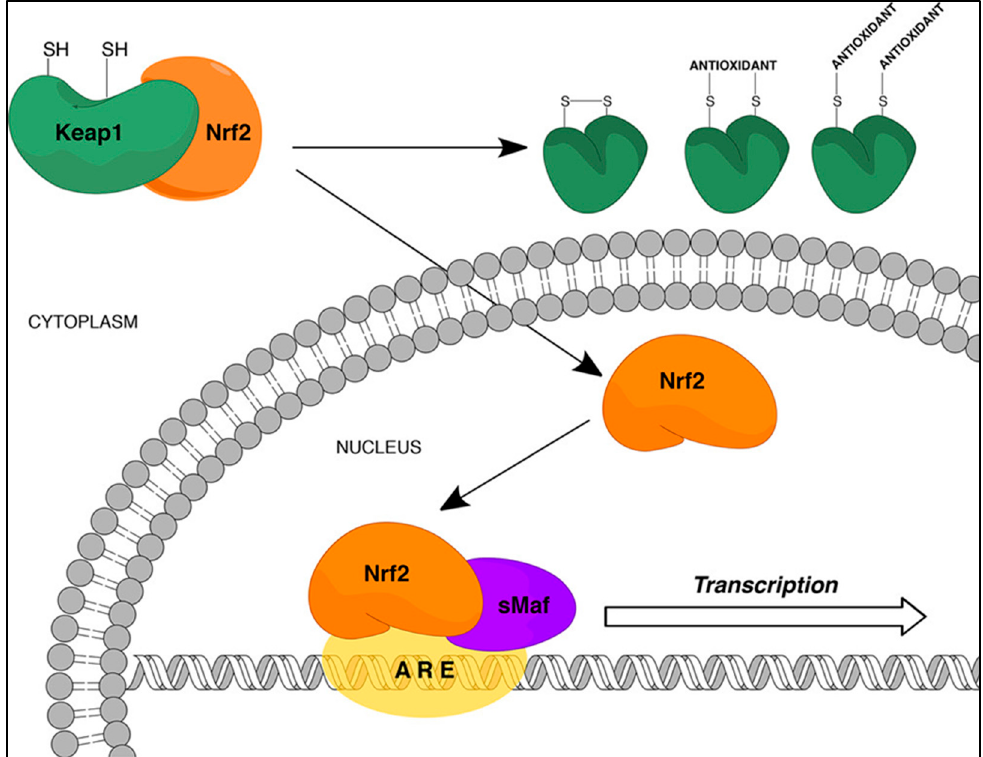
Figure 5. The mechanism by which Nrf2 promotes expression of genes that contain the ARE ele- ment. The migration of Nrf2 to the nucleus is made possible by the disruption of the Keap1–Nrf2 complex [47].